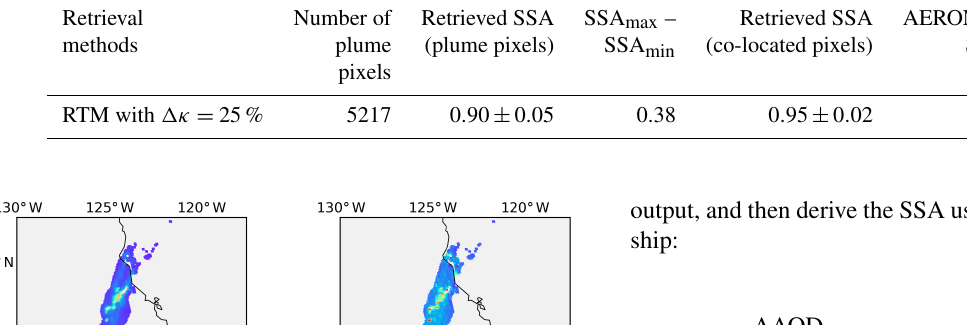
Table 2. Retrieved SSA using the radiative transfer simulations for the Californian fire on 12 December 2017. Retrieval